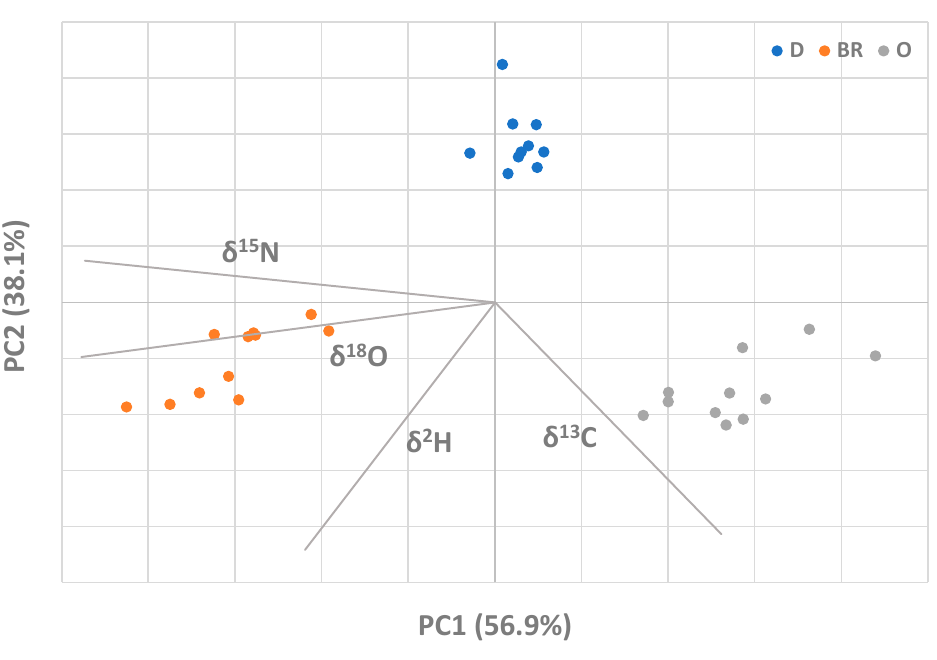
Figure 2. Principal Component Analysis resulting from isotopic results (Djebel (D), Bou-Rebiaa (BR) and Oueslatia (O) groups are labelled by blue, orange and grey spots, respectively).